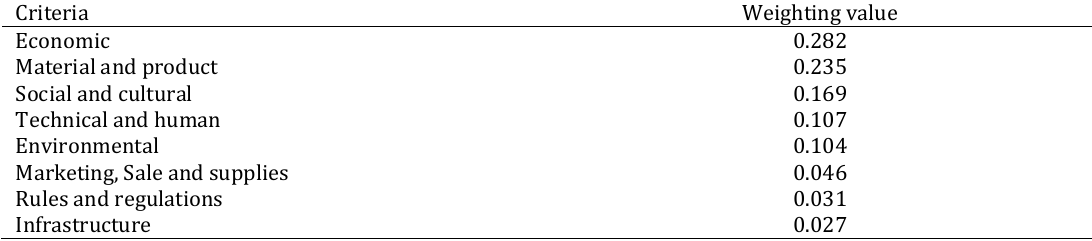
Table 1: Weighting values of main criteria (Inconsistency ratio =